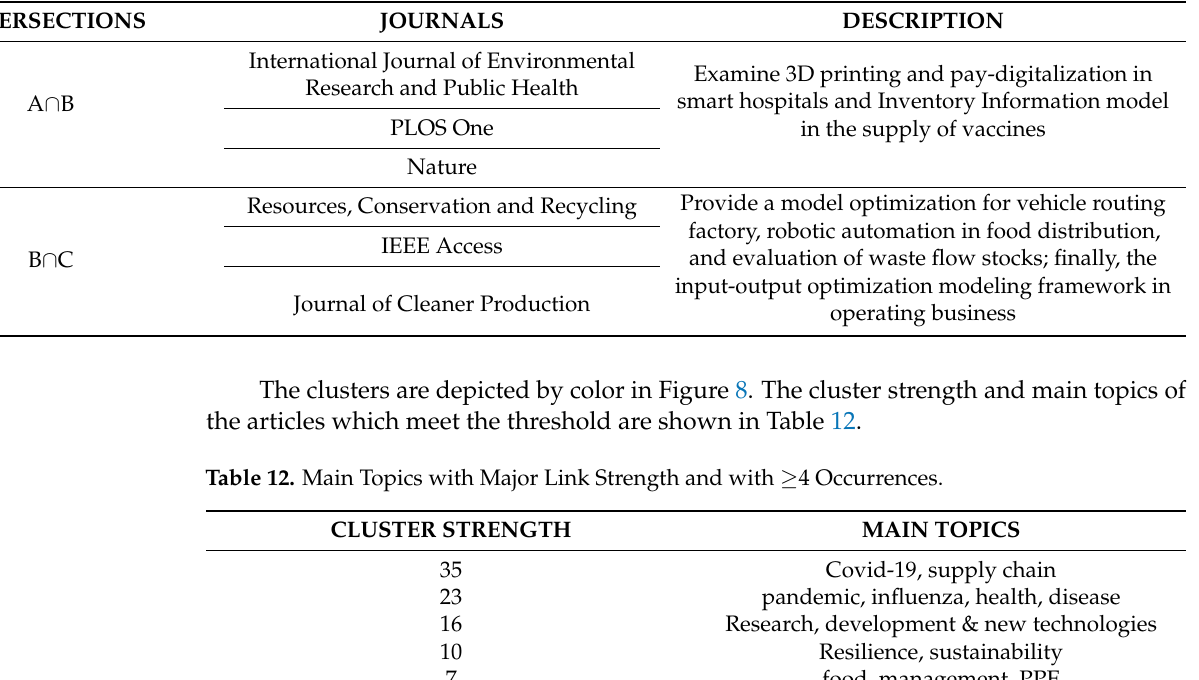
Table 11. Intersection Articles Analysis.